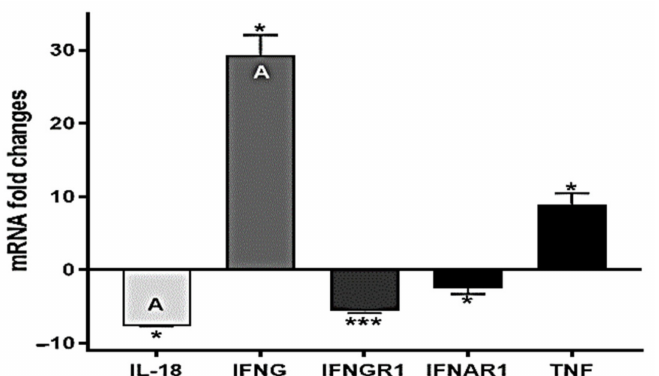
Figure 4. IL-18, IFN γ , IFN α R1, IFN γ R1, and TNF mRNA fold-change following a 24 h co-culture of ST285 with monocytes ( n = 3), compared to control monocytes. The innate and adaptive RT 2 gene profiler arrays were used to determine changes in gene expression. The symbols represent the